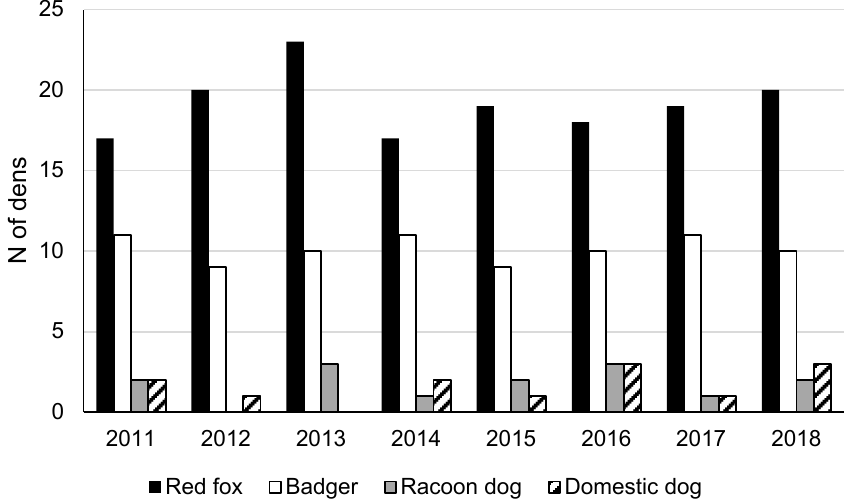
Figure 2. Numbers of dens with cubs of the three medium-sized carnivores and feral/stray dogs recorded annually in the study area (field and forest mosaic, Central Poland) in the eight-year study period.